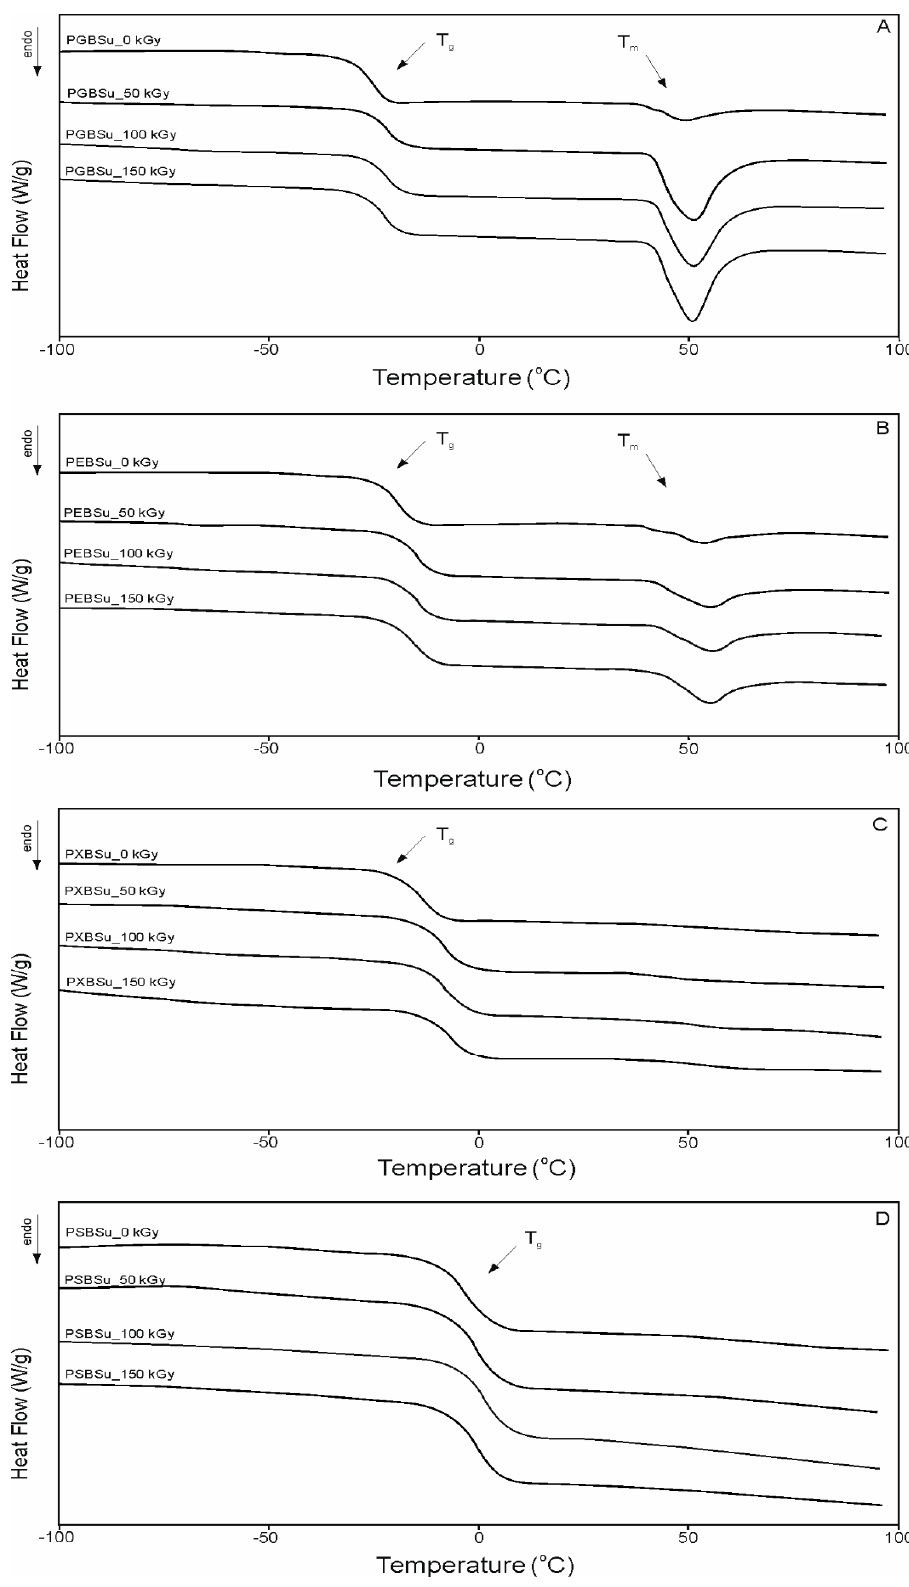
Figure 5. Differential scanning calorimetry (DSC) thermograms for first heating. ( A ) PGBSu, ( B ) PEBSu, ( C ) PXBSu, and ( D ) PSBSu before and after irradiation.